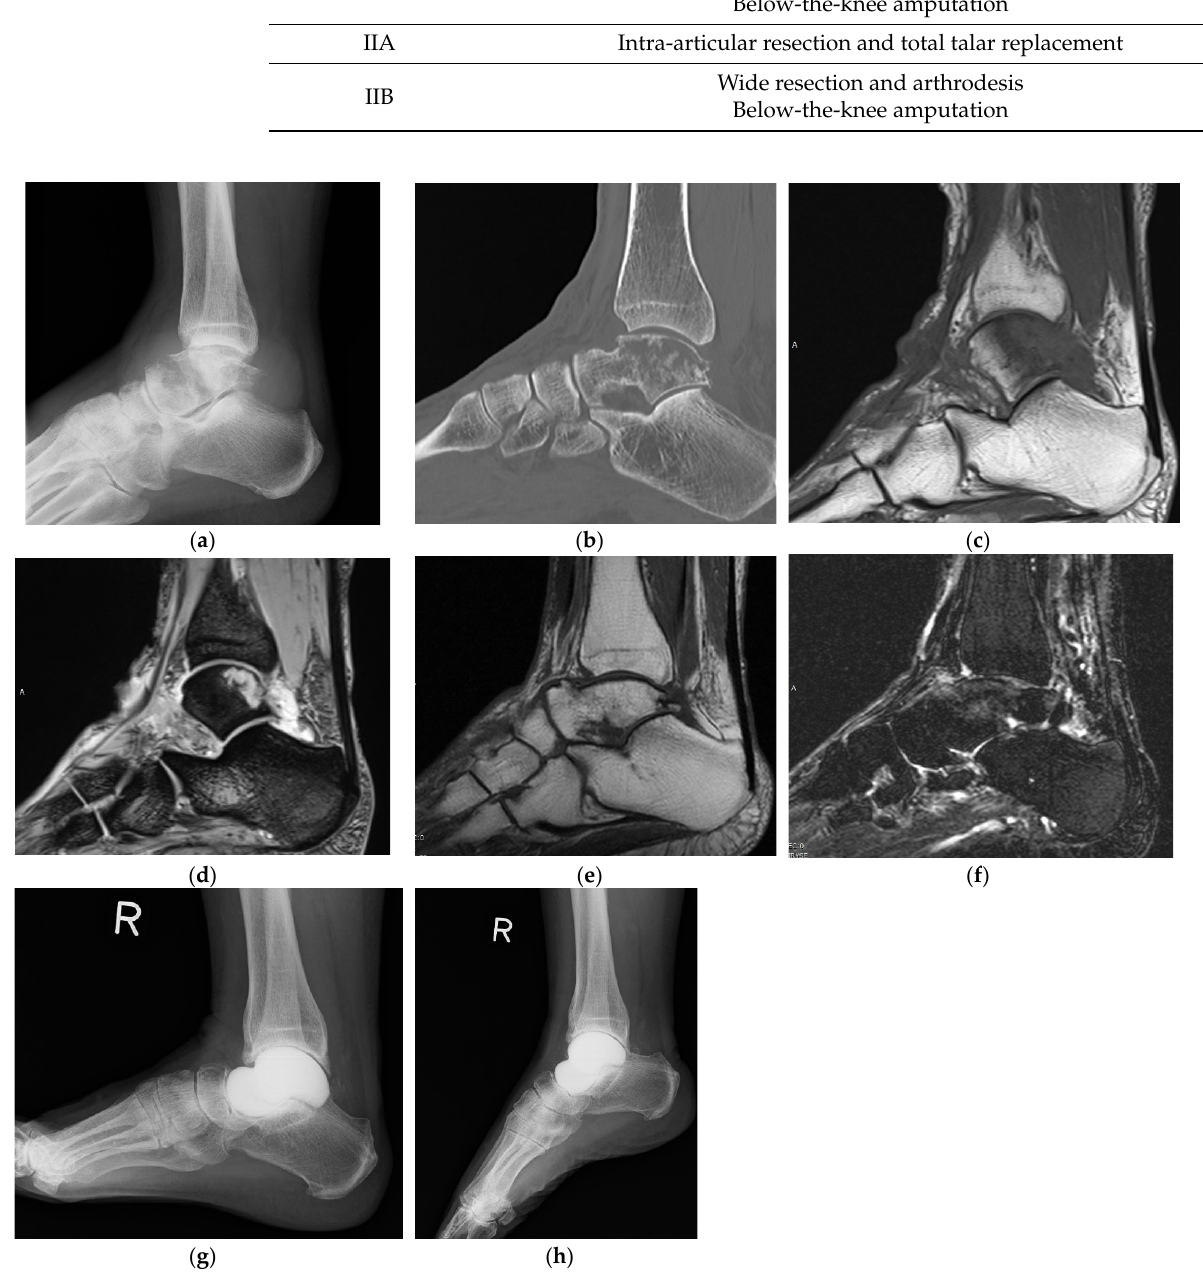
Figure 2. Primary diffuse large B-cell lymphoma of the talus (stage IA) in a 74-year-old woman. The patient presented with a chief complaint of ankle pain and swelling. ( a ) Radiography showed oste- olytic lesions and talar body collapse. Soft tissue shadows were also seen anterior and posterior to the ankle joint. ( b ) Computed tomography showed diffuse osteolytic lesions and talar body collapse. ( c , d ) Magnetic resonance imaging (MRI) showed low-signal-intensity lesions on T1WI and high- signal-intensity lesions on T2WI in the posterior part of the talar body and the extraskeletal area ( c : T1WI; d : T2WI). A needle biopsy was performed, and a diagnosis of diffuse large B-cell lymphoma was made. ( e , f ) After six courses of rituximab, cyclophosphamide, doxorubicin, vincristine, and prednisolone, MRI showed a marked reduction in tumor size ( e : T1WI; f : T2WI); however, the pa- tient had severe ankle joint pain due to the talar body collapse that was treated with talar tumor resection and total talar prosthesis reconstruction [36,47]. ( g , h ) Six years after surgery, osteosclerotic changes were observed in the distal tibia and calcaneus; however, the patient was able to walk un- aided without pain. No tumor recurrence was observed ( g : dorsiflexed position; h : plantar flexed position).